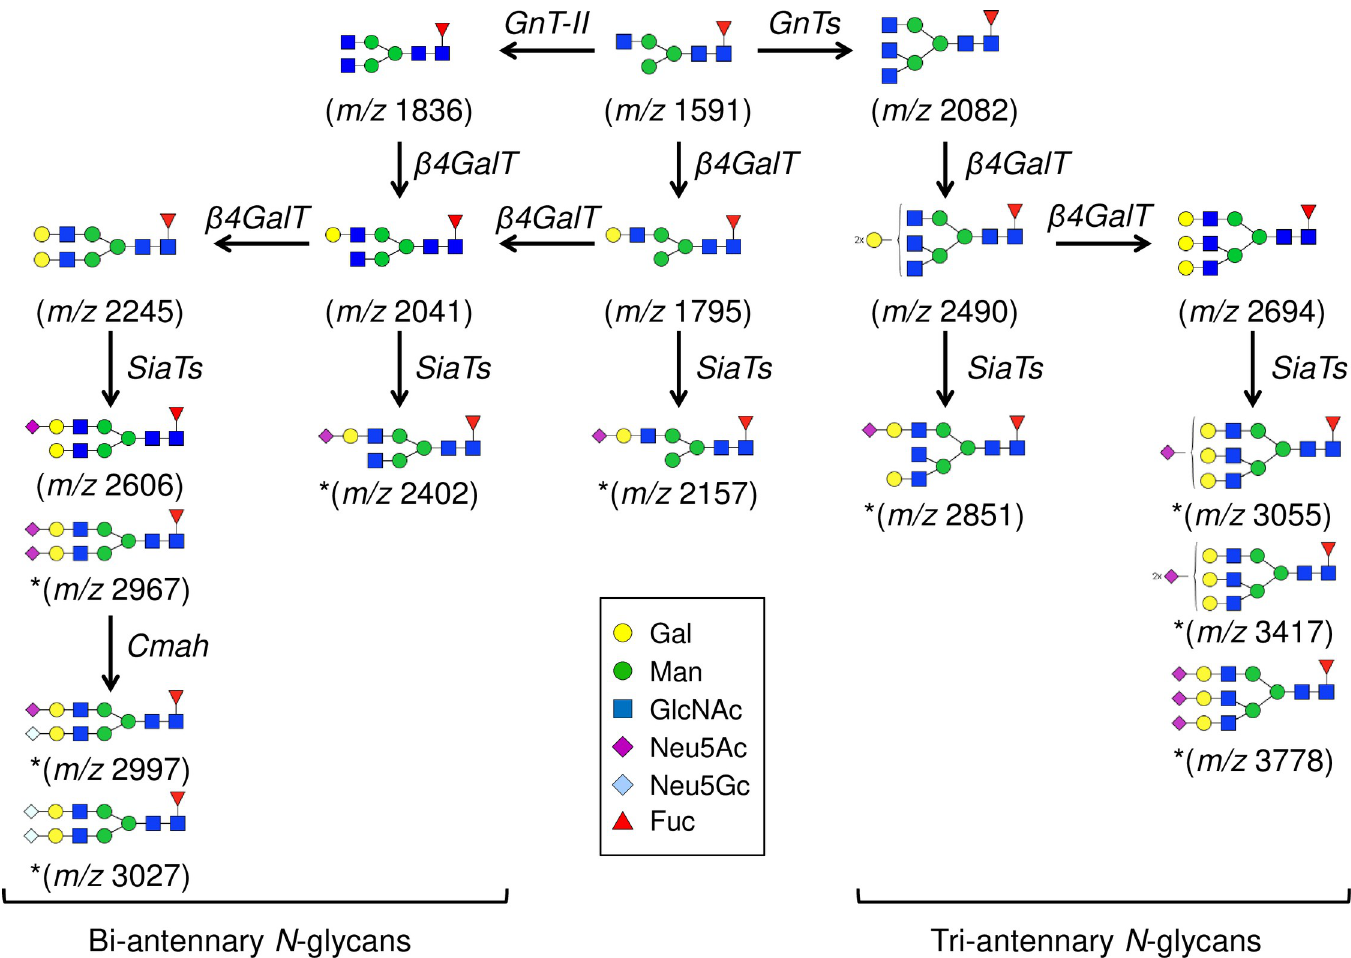
Fig 4. Biosynthetic pathways of bi- and tri-antennary N-glycans. β 4GalT, beta-1,4-galactosyltransferase; Cmah, cytidine monophospho- N -acetylneuraminic acid hydroxylase; GnT, N -Acetylglucosaminyltransferases; SiaTs, Sialyltransferases.